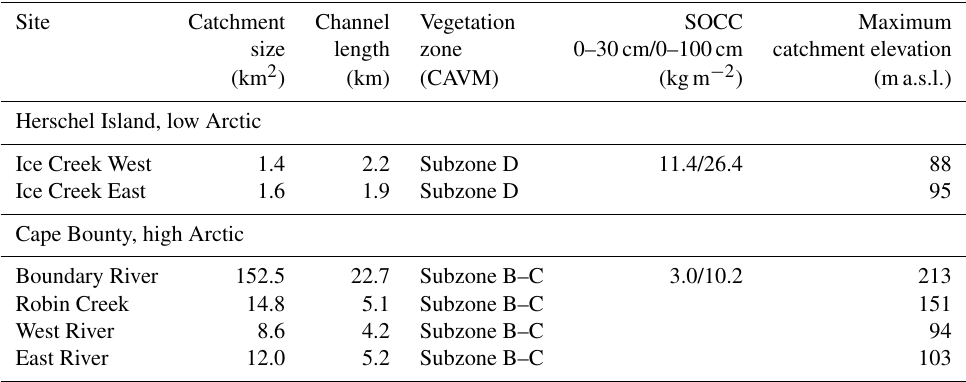
Table 1. Characteristics of studied watersheds on Herschel Island (low Arctic) and Cape Bounty (high Arctic) showing catchment size (km 2 ), channel length (km), circumarctic vegetation map (CAVM) bioclimatic zone (CAVM, 2003), soil organic carbon content (SOCC) (Hugelius et al., 2013; Ramage et al., 2019), and maximum catchment elevation above sea level